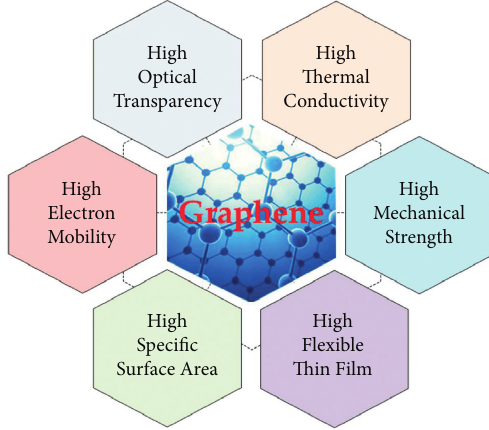
Figure 2: Properties of graphene